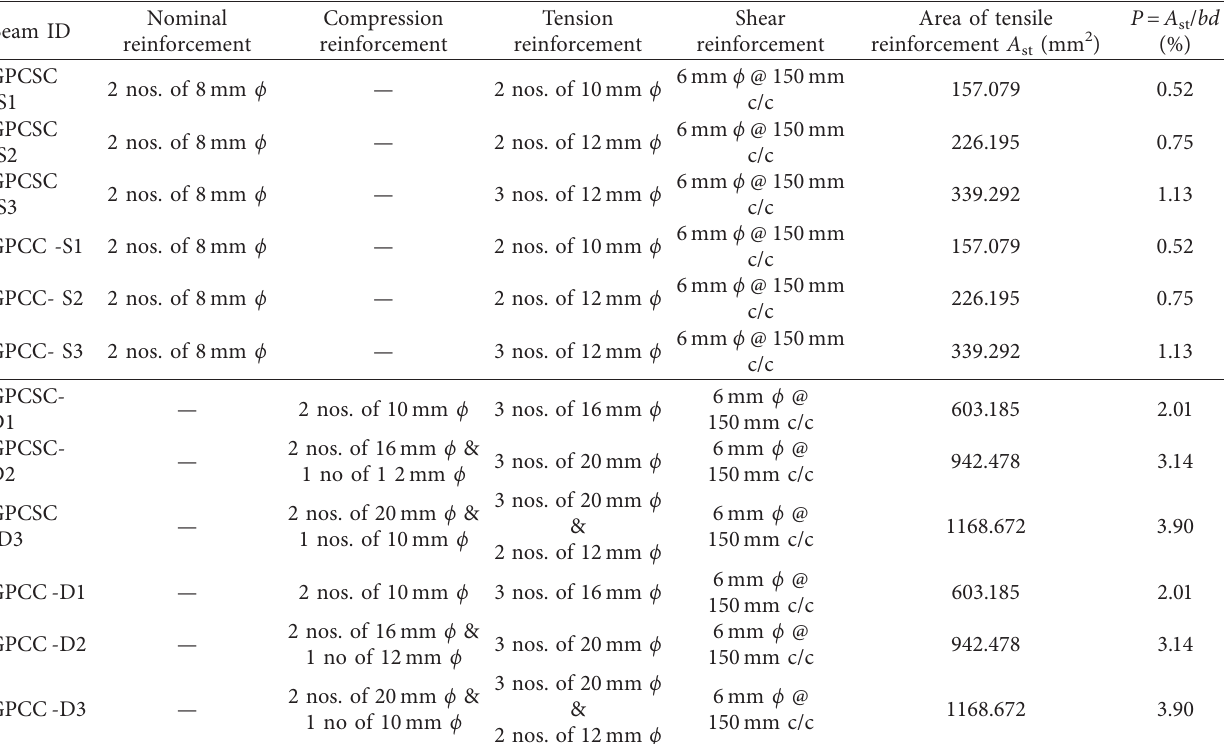
Table 4: Beam details (width, 150mm; effective depth, 200mm; and overall length, 3000mm).